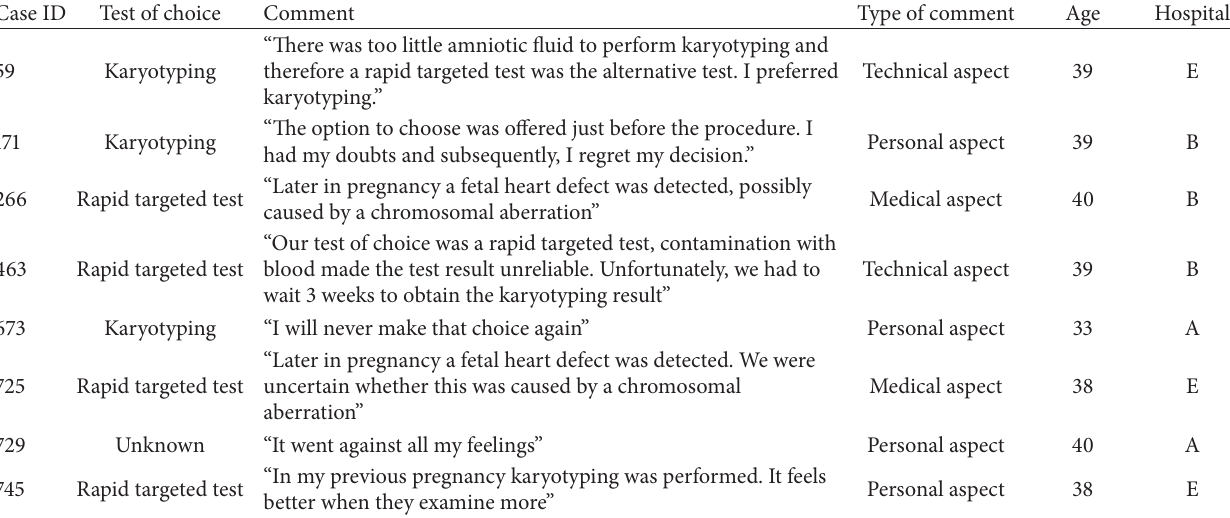
Table 3: Comments from the respondents who showed regret about their choice.